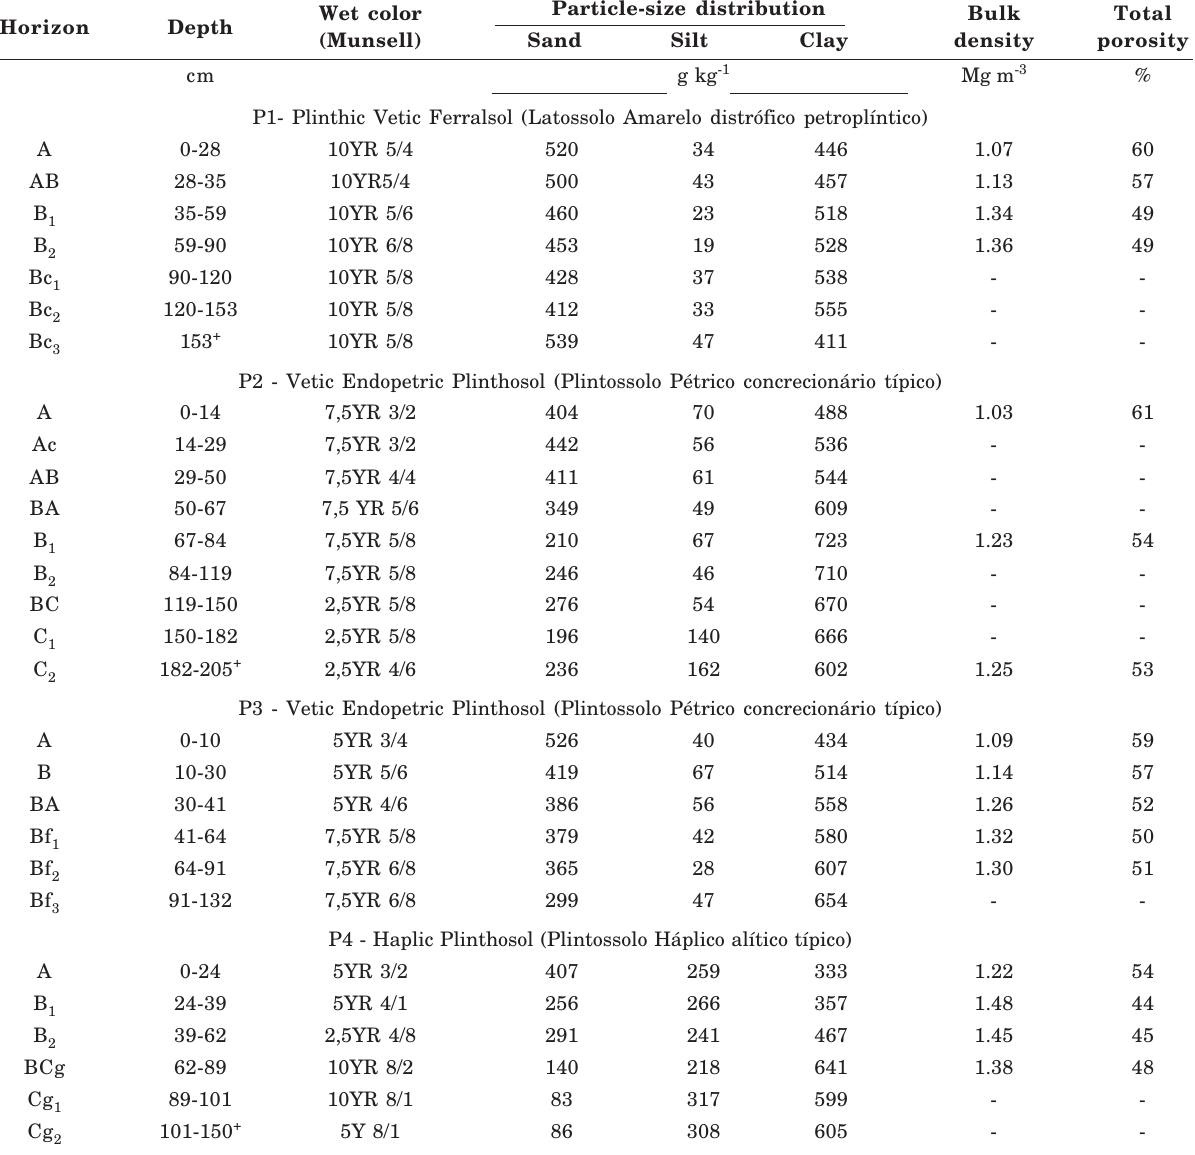
Table 1. Morphological and physical properties of four soils studied in Iranduba